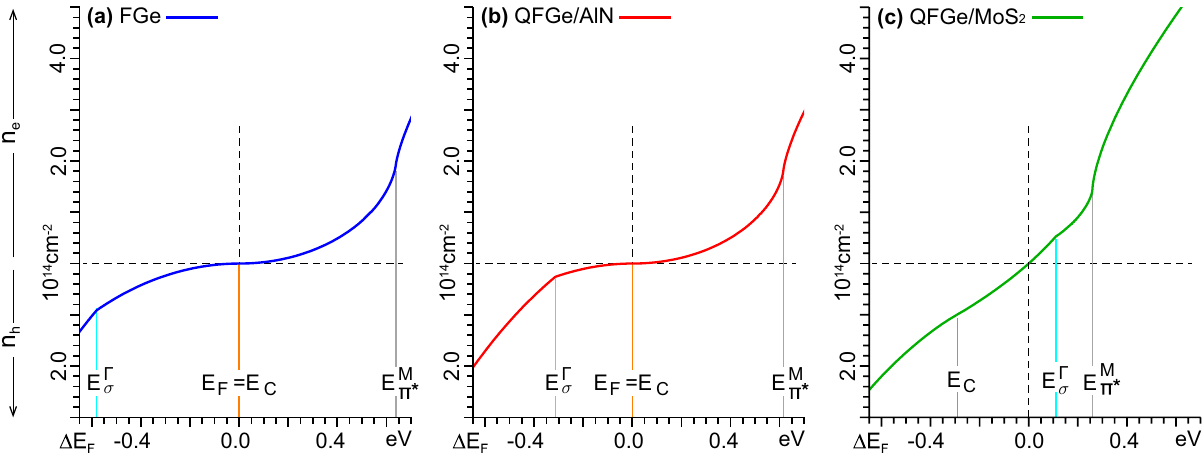
Figure 2. Electron ( n e ) or hole ( n h ) carrier concentrations vs � E F > 0 or � E F < 0 in ( a ) FGe, ( b ) QFGe on AlN , 0 denoting the charge neutrality point. E Ŵ σ , E C , and E π ∗ and ( c ) QFGe on MoS 2 , with (cid:31) E F = Fig. 1( a )–( c ), are associated to non-smooth, distinct trends of the three curves.